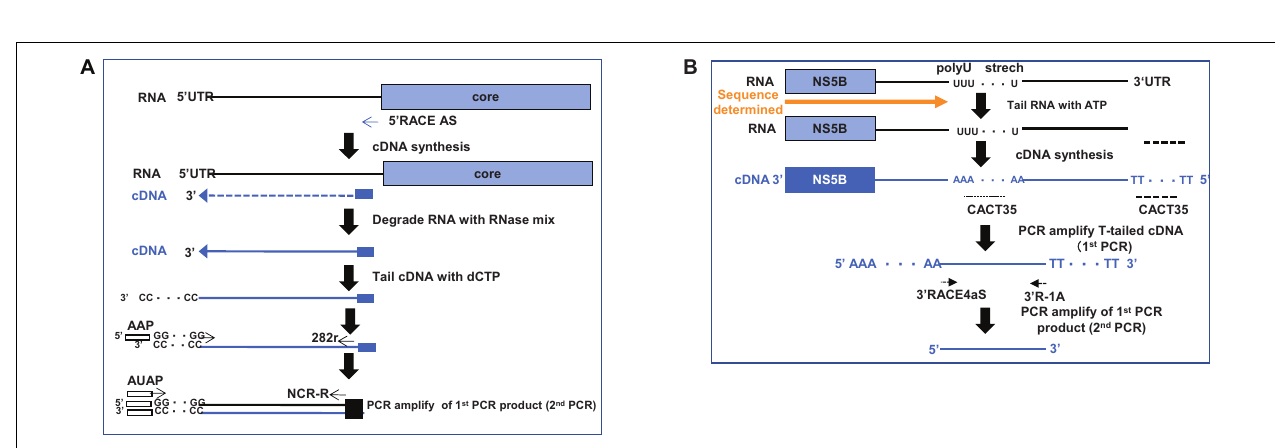
FIGURE 3 | Strategy to clone HCV-G4 5 (cid:48) and 3 (cid:48) terminal regions. (A) Schematic of 5 (cid:48) RACE strategy to clone 5 (cid:48) -terminal region of HCV-G4. (B) Schematic of 3 (cid:48) RACE strategy to clone 3 (cid:48) -terminal region of HCV-G4.